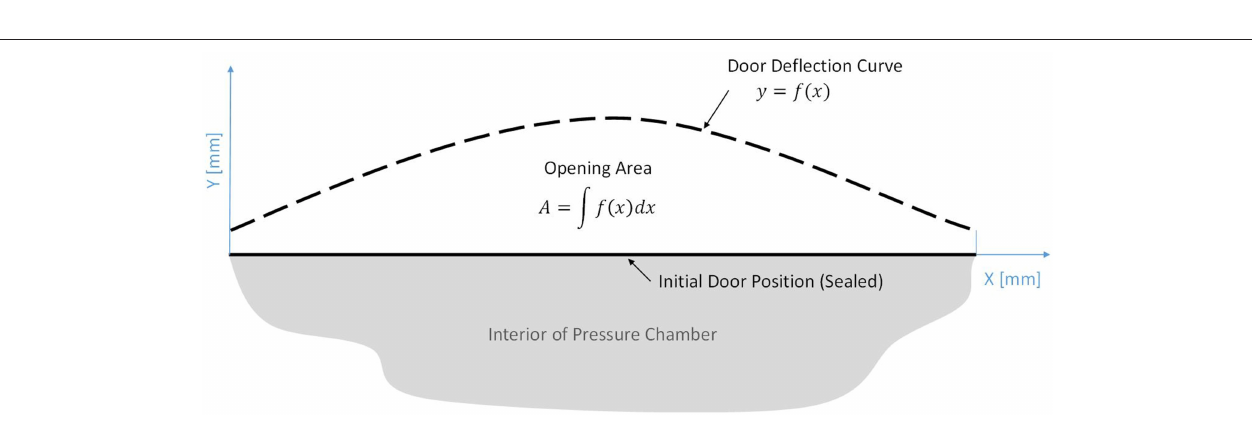
FIGURE 9 | Conceptual image of a garage door deflection curve at its top edge. The opening area is equivalent to area under the curve.